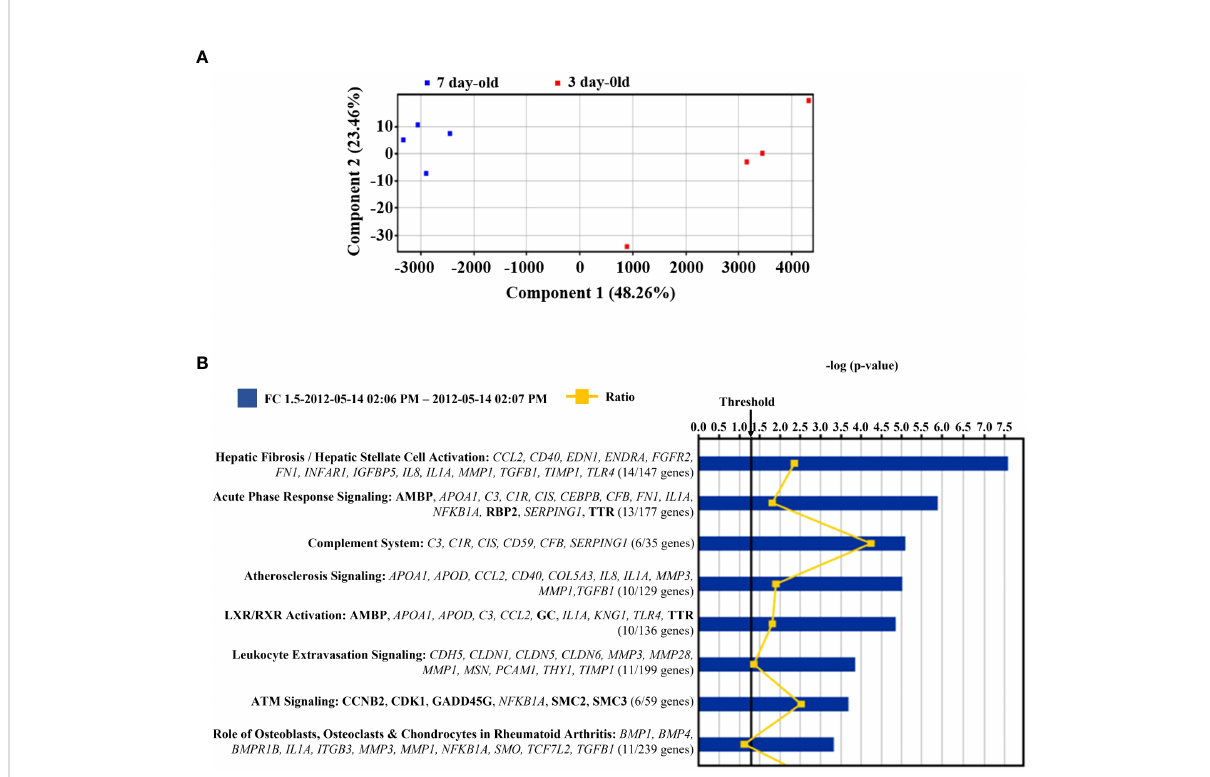
FIGURE 5 Microarray analysis of islets from 3- and 7-day-old pigs. (A) Principal component analysis of eight samples of islets isolated from 3- and 7-day- old pigs. The red and blue squares denote islets from 3-day-old and 7-day-old pigs, respectively. The x-axis and y-axis are a visual representations of unidenti fi ed vectors that separate the samples. This fi gure displays the difference between islets from 3- and 7-day-old pigs. (B) Canonical pathways represented in the differentially expressed genes between islets from 3- and 7-day-old pigs. The p-value is calculated by Fisher ’ s Exact Test and is displayed in blue as a – log with more signi fi cant pathways being higher on the scale. The threshold represents a p- value of 0.05. The orange line displays the ratio of genes that are signi fi cantly expressed between the groups and the total number of genes in each pathway. This ratio is also written under each pathway. The genes from the signi fi cance analysis are displayed directly under each pathway. The non-bold genes denote up-regulation, and the bold genes denote down-regulation.